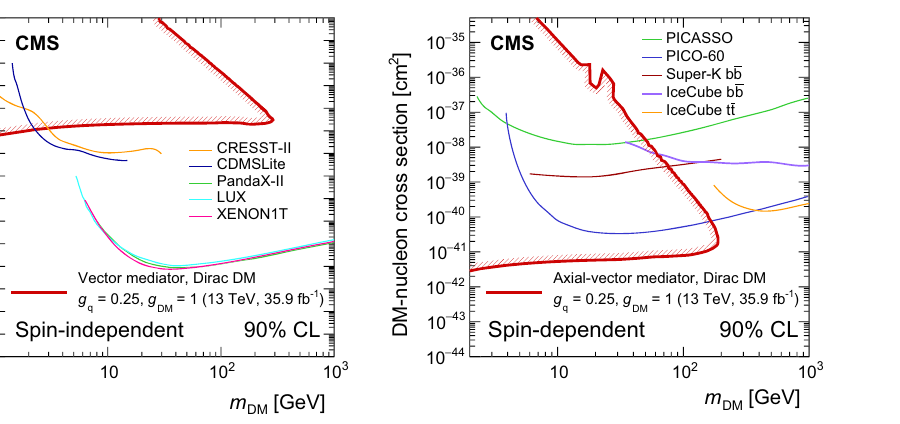
pseudoscalar scenarios. In Fig. 7, limits on the DM-nucleon scattering cross section are set at 90% CL as a function of the DM particle mass and compared to selected results from direct detection experiments. Both spin-dependent and spin- independent cases are considered. In both cases, couplings g q = 0 . 25 and g DM = 1 are